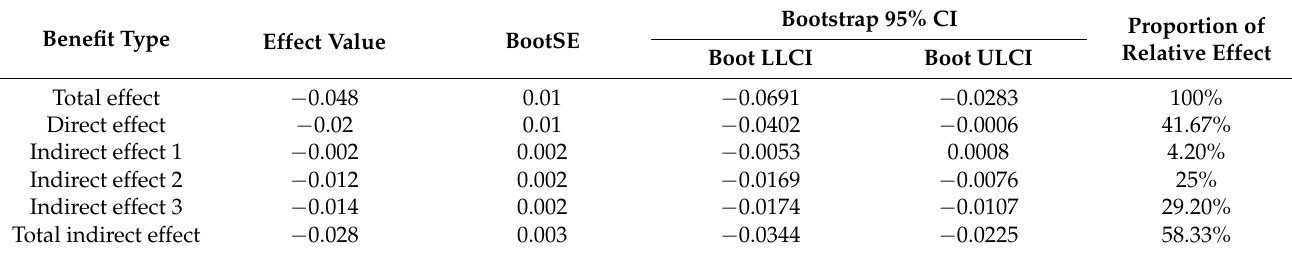
Table 4. Chain-mediated model effect tests for psychological capital and social